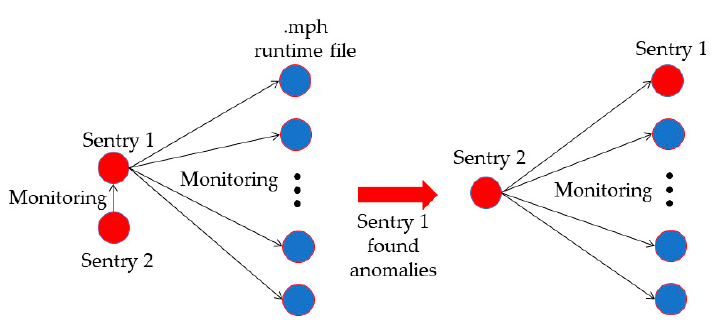
Figure 9. “Sentry” operation process.